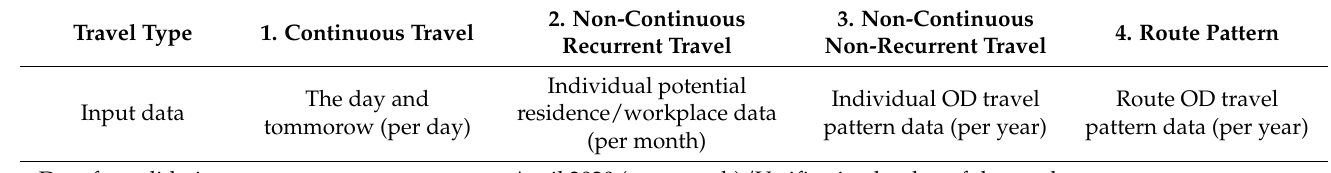
Table 3. Utilization data for estimating destination of bus trip by travel